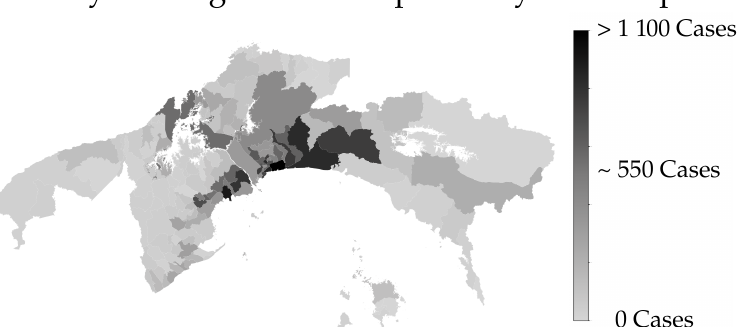
Figure 2. Map with the scale distribution of the accumulated number of reported cases of Dengue in the Metropolitan Region.